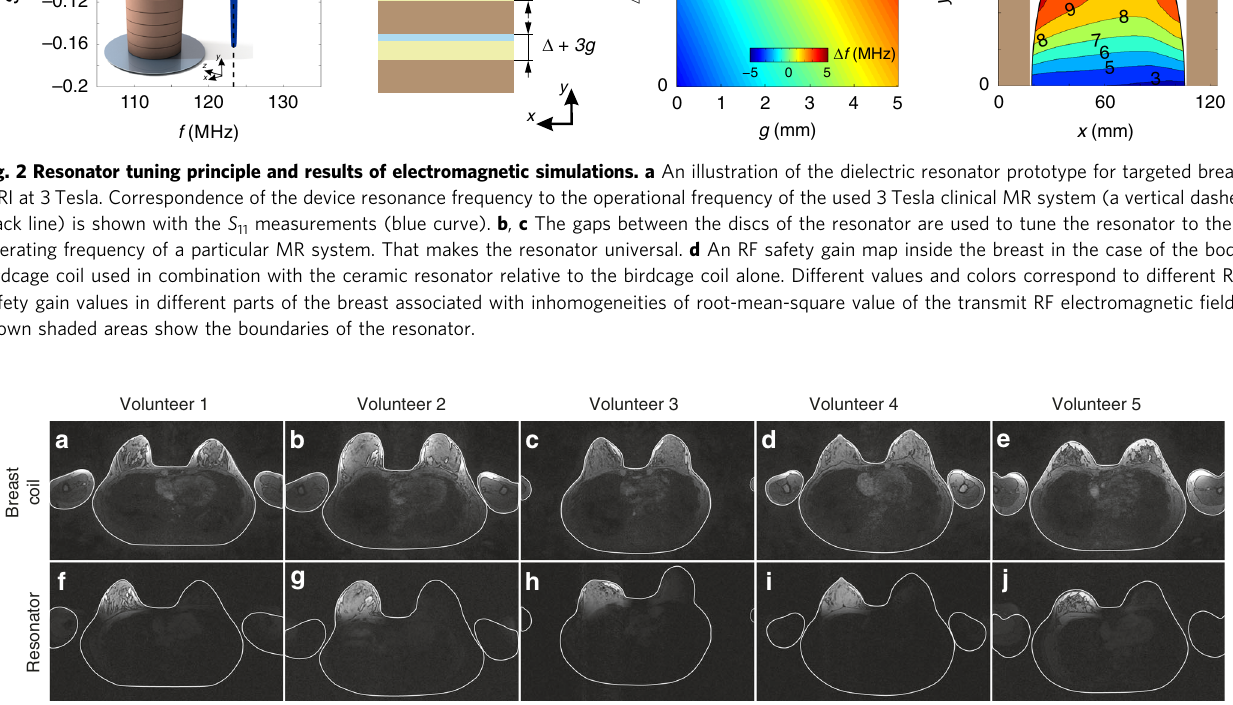
Fig. 3 Experimental demonstration of targeted MR concept. a – e MR images acquired for fi ve healthy volunteers of BMI range 17.1 – 21 kg/m 3 with the conventional methods: MR signal was excited through the body birdcage coil and received by 16-channel breast coil. f – j MR images acquired for the same volunteers with the transmitting/receiving birdcage coil together with the proposed prototype of the